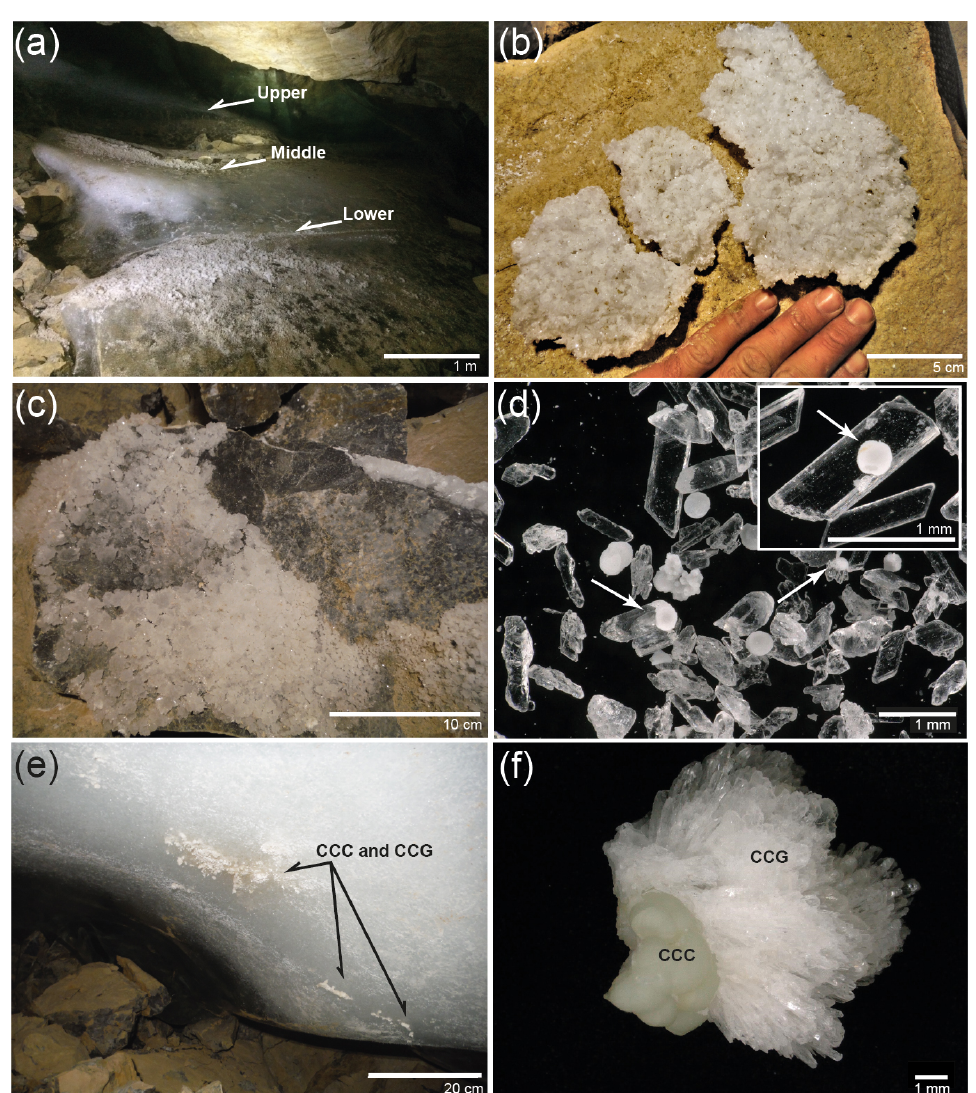
Figure 9. (a) Ice body in room G and three levels marked by cryogenic gypsum partially still in situ in the ice. The white area corresponds to milky ice with a high abundance of air inclusions. Gypsum crystals cover parts of the surface of the ice body due to ice retreat. (b) Large gypsum “raft” deposited on a block in room D. (c) Block in room D with gypsum overgrowths. (d) Microscopic image of euhedral CCG with cores of CCCs (white arrows) and globular CCCs and enlarged image of euhedral gypsum crystal with a nucleus of globular CCCs. (e) CCCs and CCG entrapped within milky ice in room G. (f) Detail of a CCC sample from room G covered by